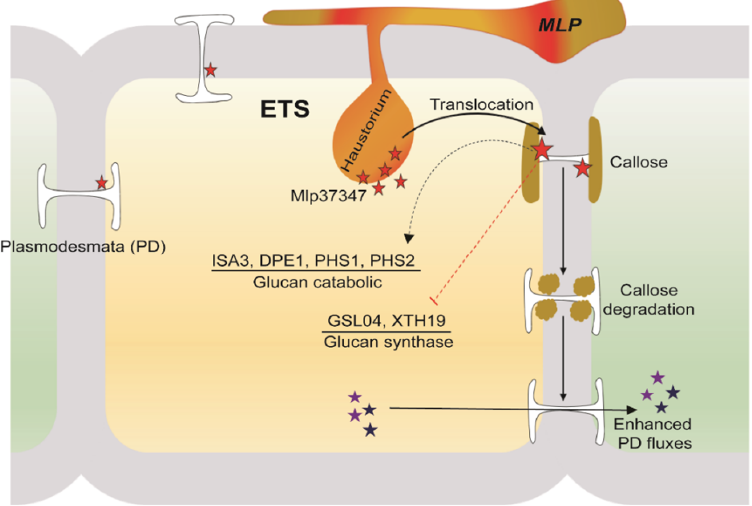
Figure 7. A hypothetical model illustrating a potential role of Mlp37347 on plasmodesmata during the infection.